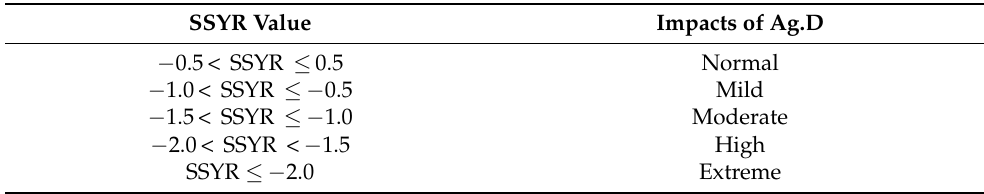
Table 3. Classification of the sequence of standardized yield residual (SSYR) values which ranged from normal conditions to extreme drought